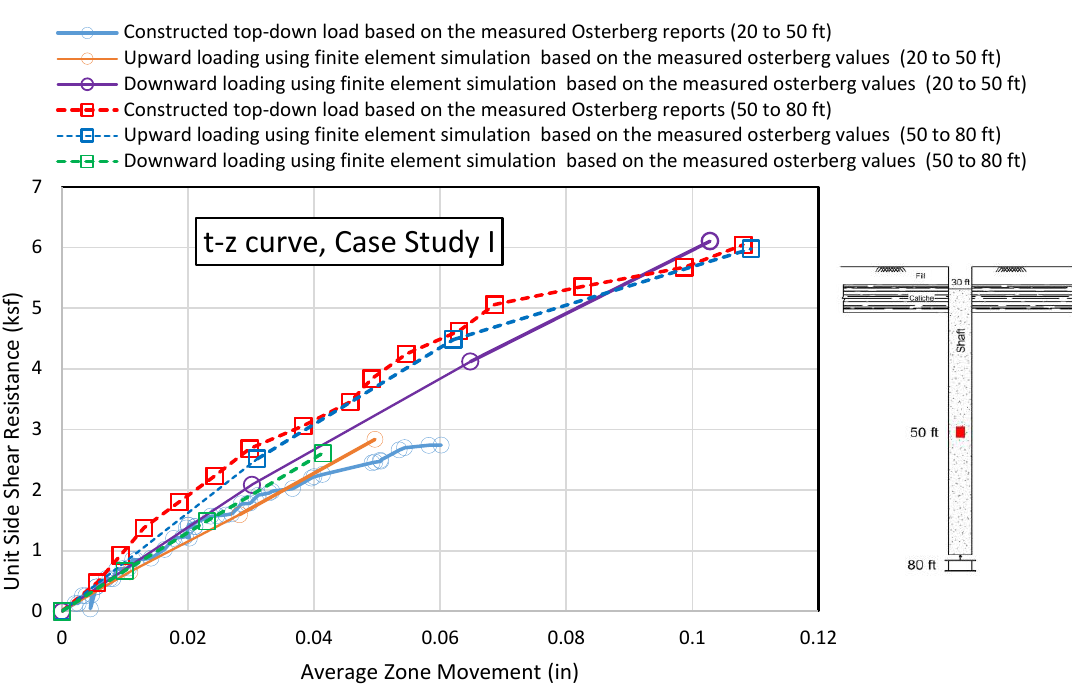
Figure 8. t – z stiffness curve for the constructed top-down load along with the upward and downward axial load finite element simulation in Case Study I.